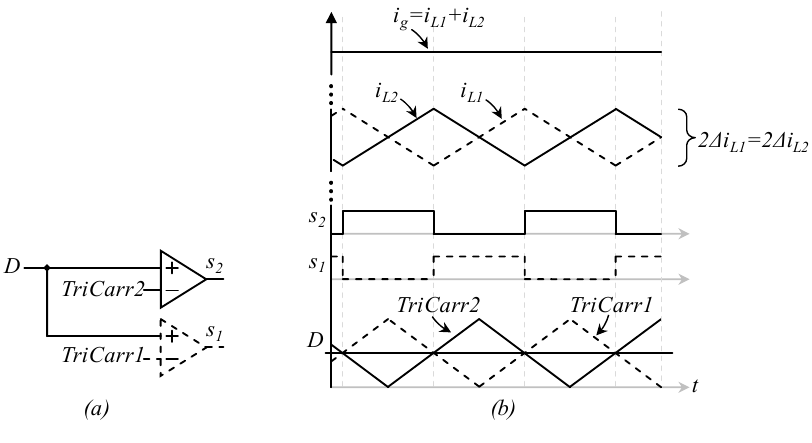
Figure 8. PWM scheme when D = 0.5.